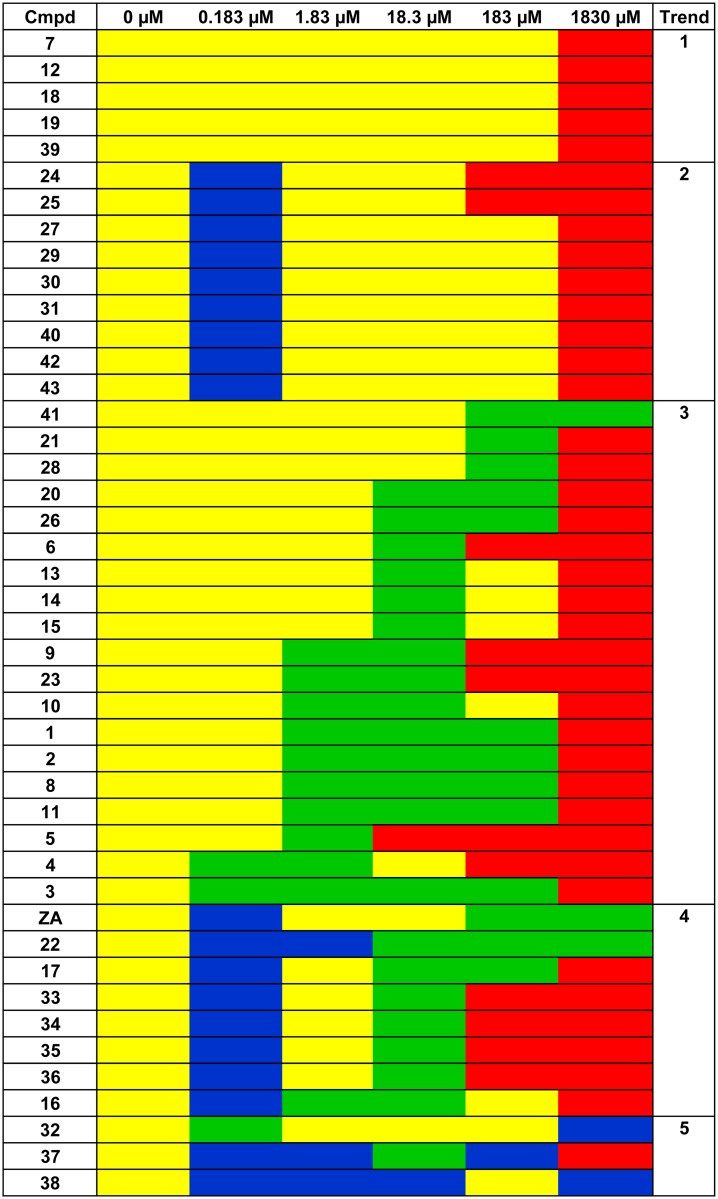
Biological activity of ZA-related compounds.Biological activity of each ZA-related compound at the different tested concentrations. For an understanding of the meaning of each trend refer to the ‘Results and discussion’ section. Yellow: no biological activity; Green: anti-biofilm activity; Blu: promotion of biofilm formation; Red: biocidal effect.